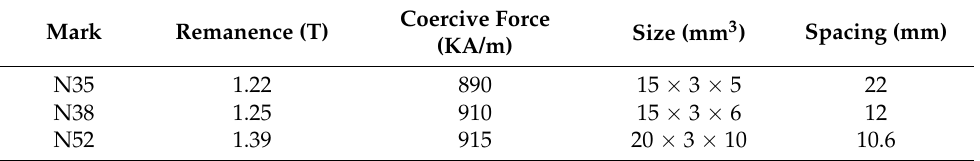
Table 2. Property and spacing of the permanent magnets N35, N38, and